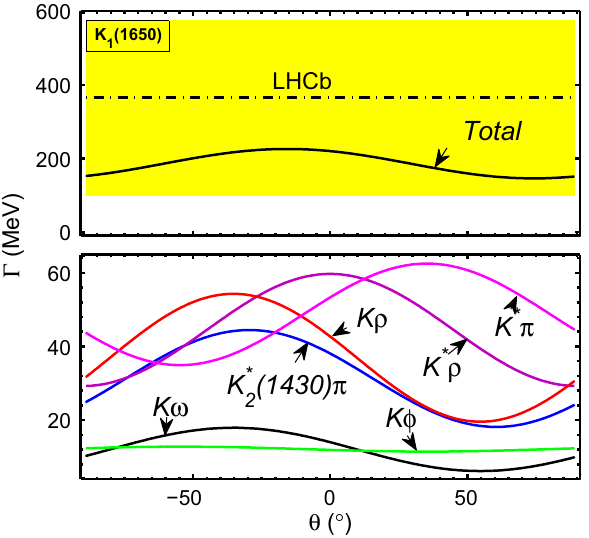
Fig. 4 θ 2 P dependence of the decay widths of K 1 ( 1650 ) as a 2 P state, where the dot-dashed line is the experimental value of OMEG [65]